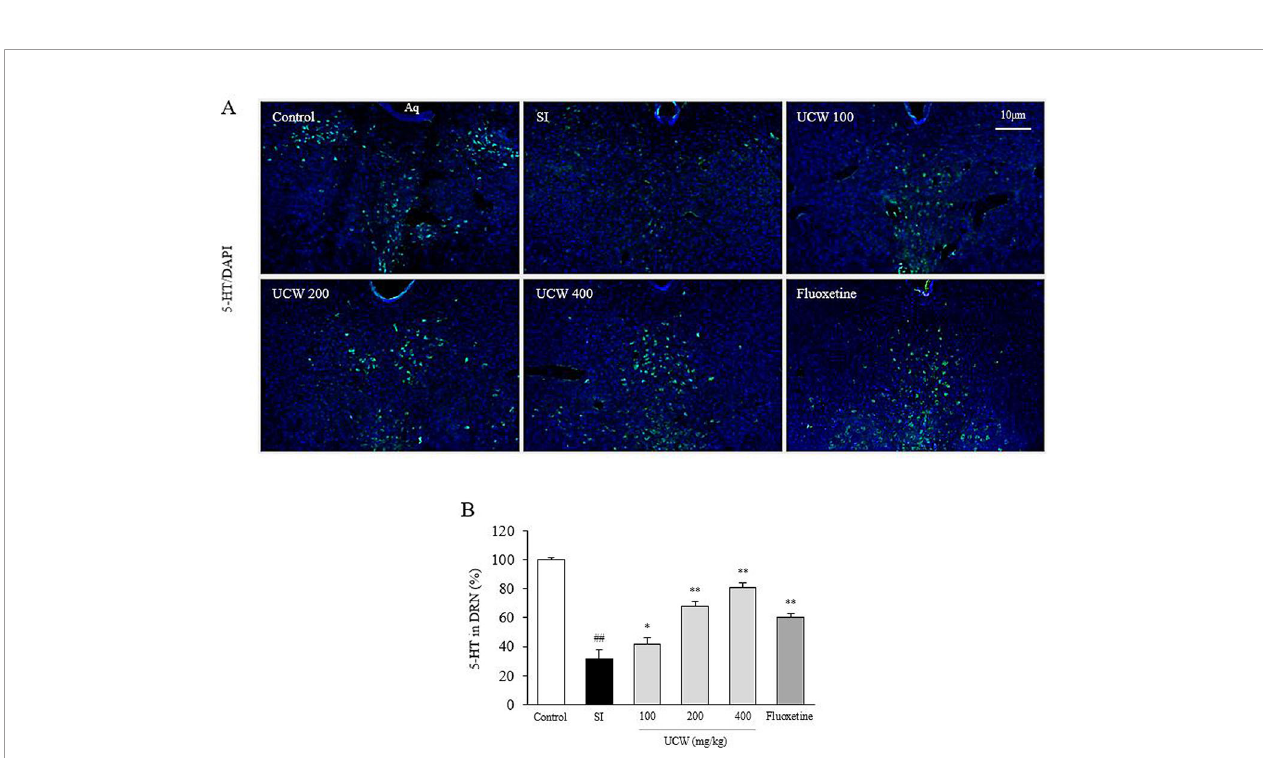
FIGURE 4 | Effects of UCW on the 5-HT relative intensity in dorsal raphe nuclei. Immuno fl uorescence of 5-HT in dorsal raphe nuclei was measured (A) and semi- quanti fi ed (B) . Data are presented as the mean ± SD (n = 3). ## P < 0.01 compared with the control group; *P < 0.05, **P < 0.01 compared with the social isolation (SI) group.